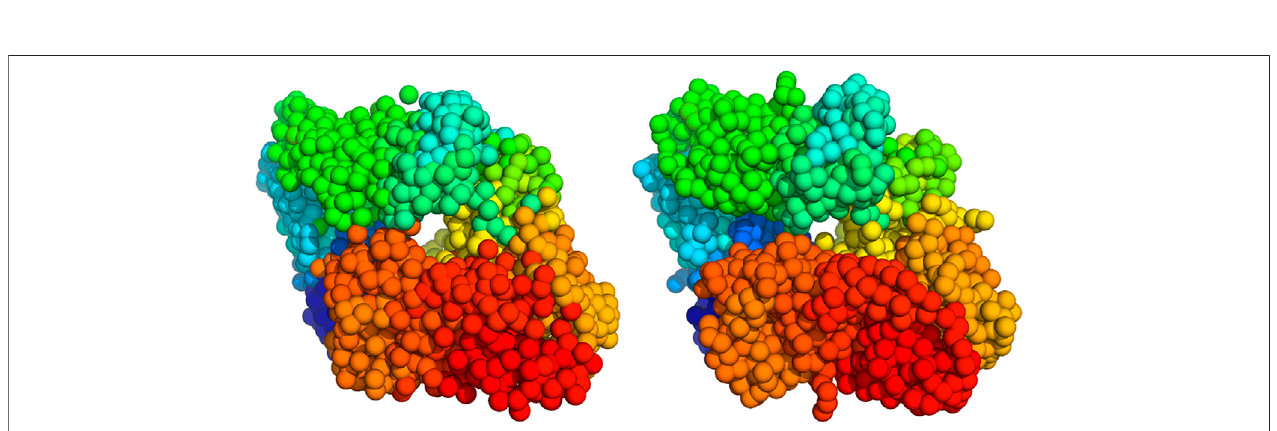
FIGURE 8 | 2D projections of beta-galactosidase. Top row: eight (out of 16) projection images (RELION class averages). Bottom row: Projection images calculated with Bayesian random tomography using 500 particles.